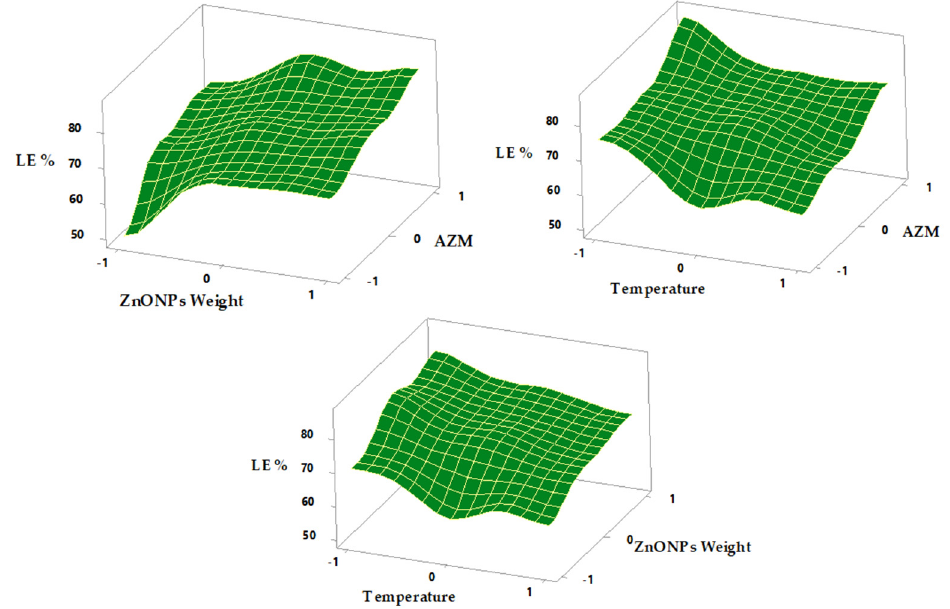
Figure 5. Surface plot effects of different formulation factors on LE%.